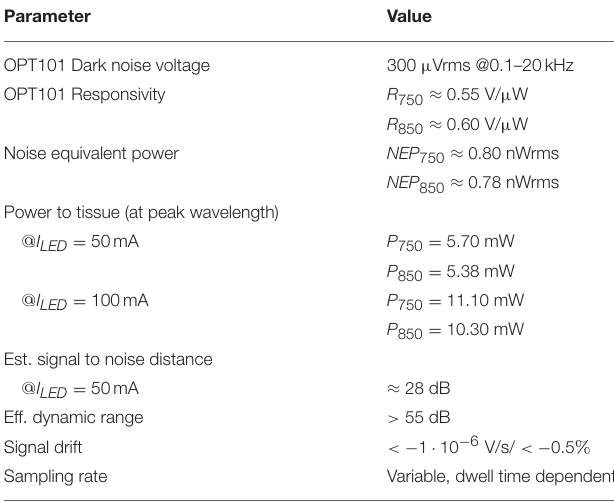
TABLE 1 | Performance characteristics of the fNIRS